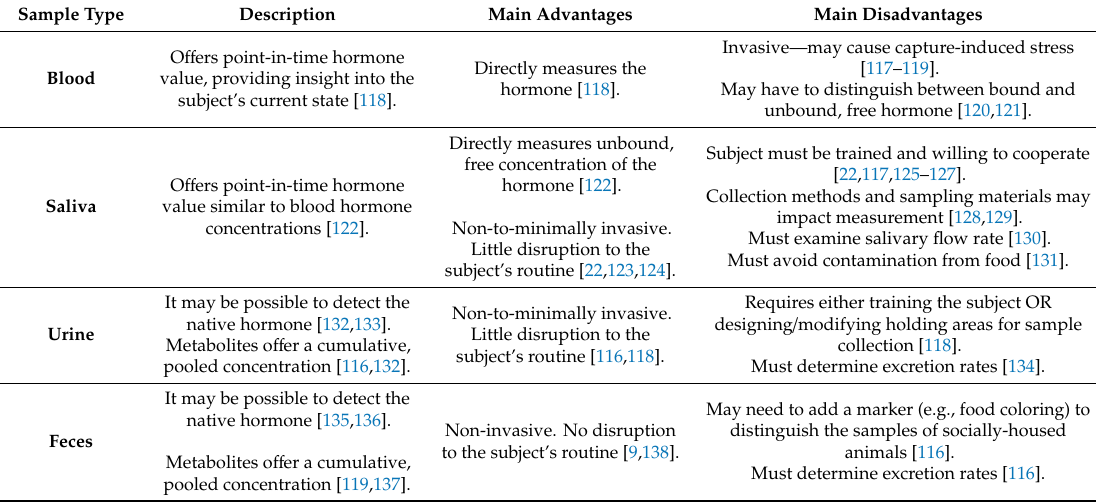
Table 1. Common sample types for examining glucocorticoids and